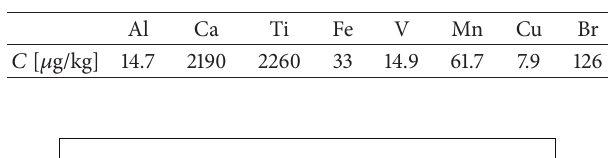
Table 1: Concentration of main impurities in Slanic Prahova mine, according to [38].